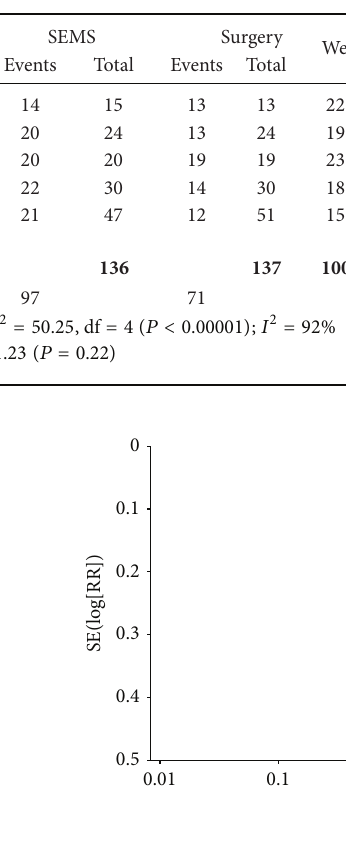
Figure 2: Primary anastomotic rate of semielective surgery after SEMS installation versus emergency